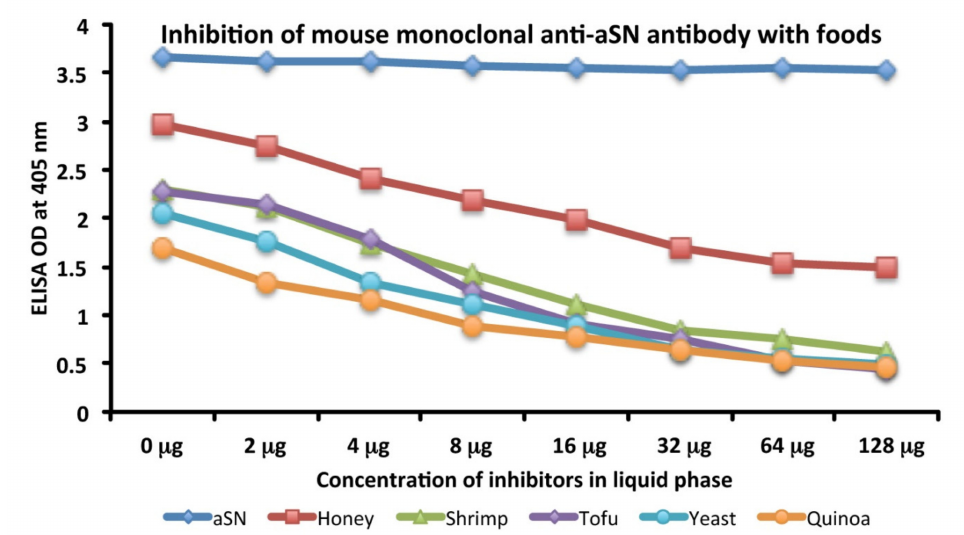
Figure 5. Analytical specificity by inhibition study for mouse monoclonal anti-aSN antibody binding to various food antigens. Graph shows the inhibition of mouse monoclonal aSN antibody with different concentrations of aSN (blue diamond), honey (red square), shrimp (green triangle), tofu (purple diamond), yeast (light blue circle) and quinoa (orange